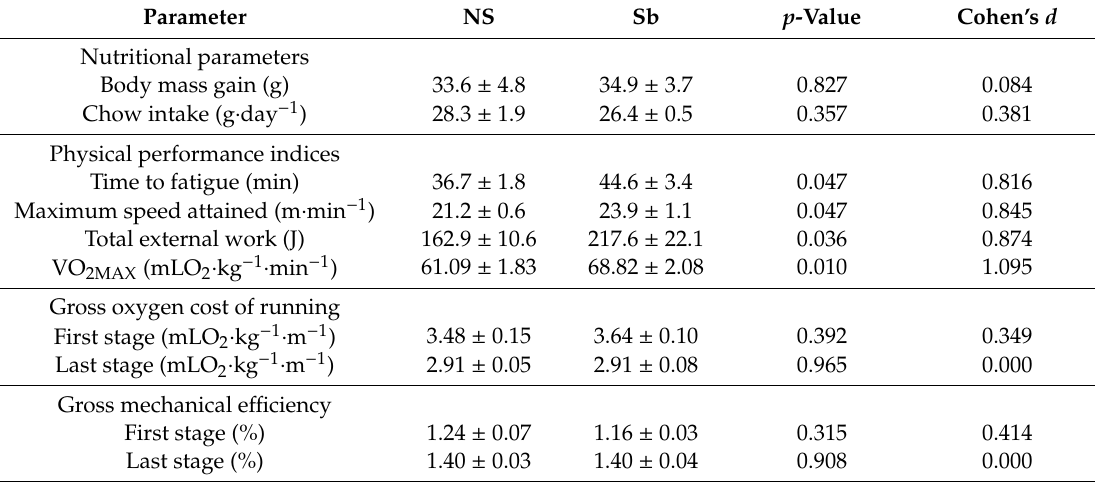
Table 1. The nutritional parameters during the 10 days before the experimental trials, the physical performance indices, running economy, and the mechanical e ffi ciency values of rats from the non-supplemented (NS) and the Saccharomyces boulardii -supplemented (Sb) groups during the incremental